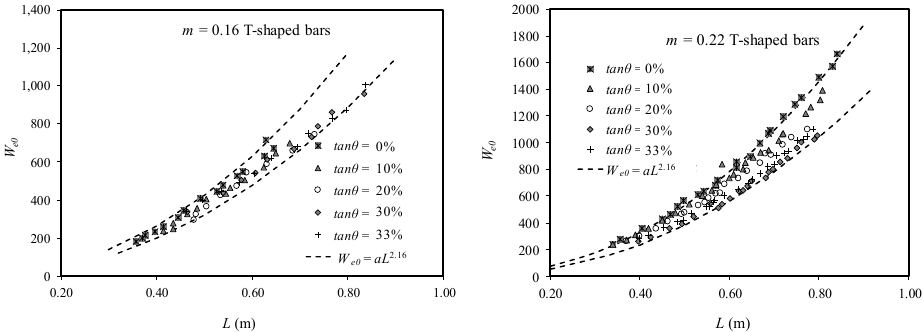
Figure 18. Weber number at the beginning of the rack W e 0 as a function of the wetted rack length L , for circular bars with void ratio m = 0.28 and 0.60.